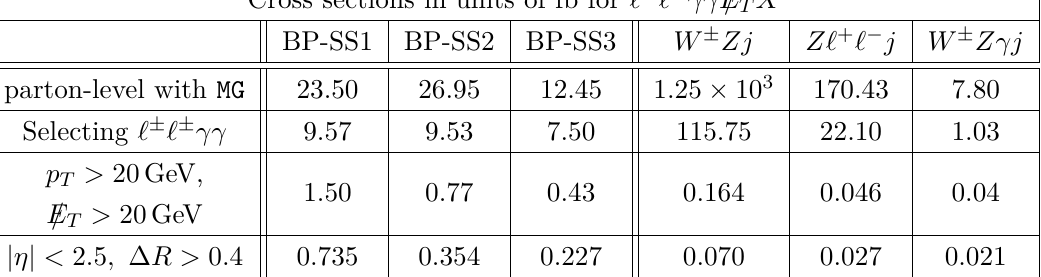
Table 4 . Cut-flow chart of the cross sections (in units of fb) for the final state γγ‘ ± ‘ ± / E T X at the 14 TeV LHC. The parton-level cross sections for the backgrounds include the branching ratios of the leptonic decays of W ± and Z